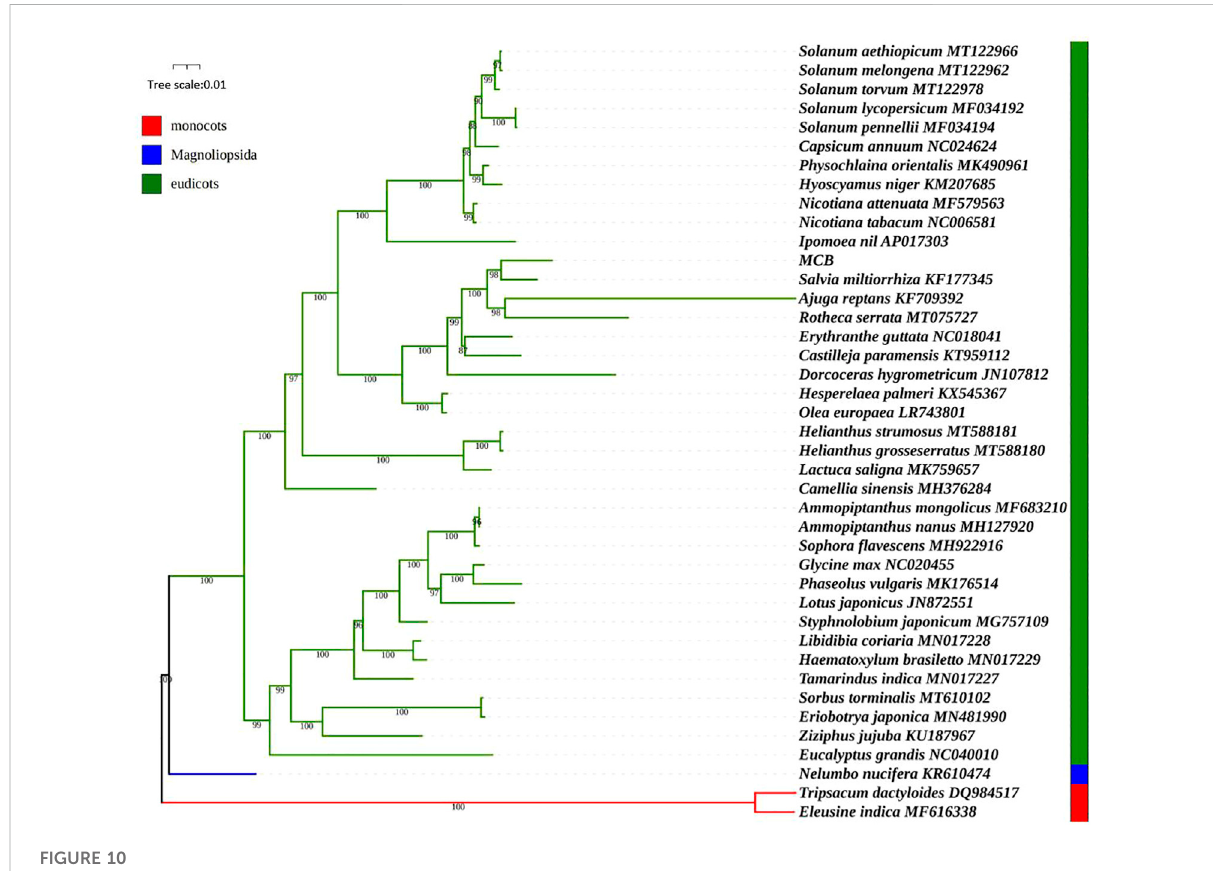
FIGURE 10 Phylogenetic analysis based on the mitogenoms of 41